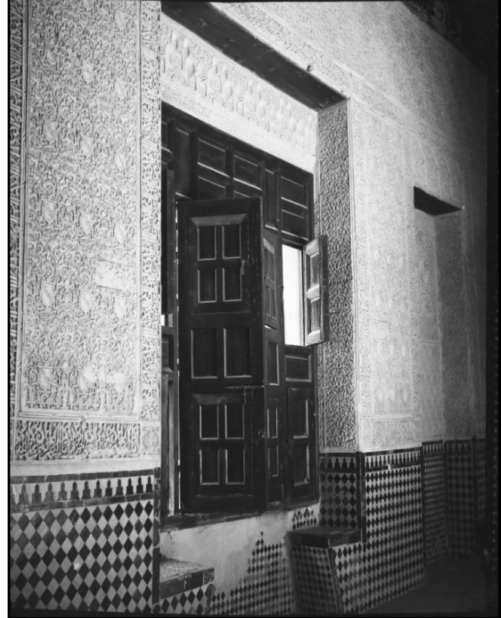
Figure 23. Ceramic dado on the north wall of the Cuarto Dorado, with pieces missing beneath the mullioned window (undated). © Archivo del Patronato de la Alhambra y Generalife, Photograph Collection,